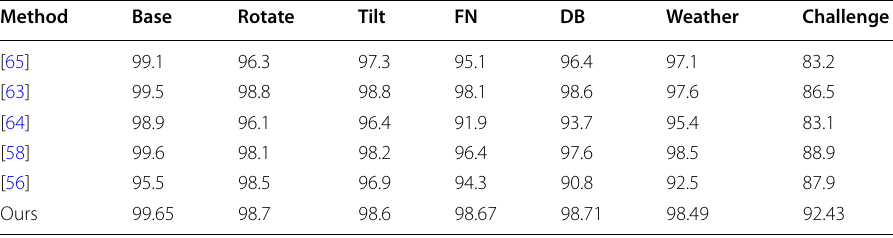
Table 5 The LP detection accuracy (%) on each CCPD subset Method Base Rotate